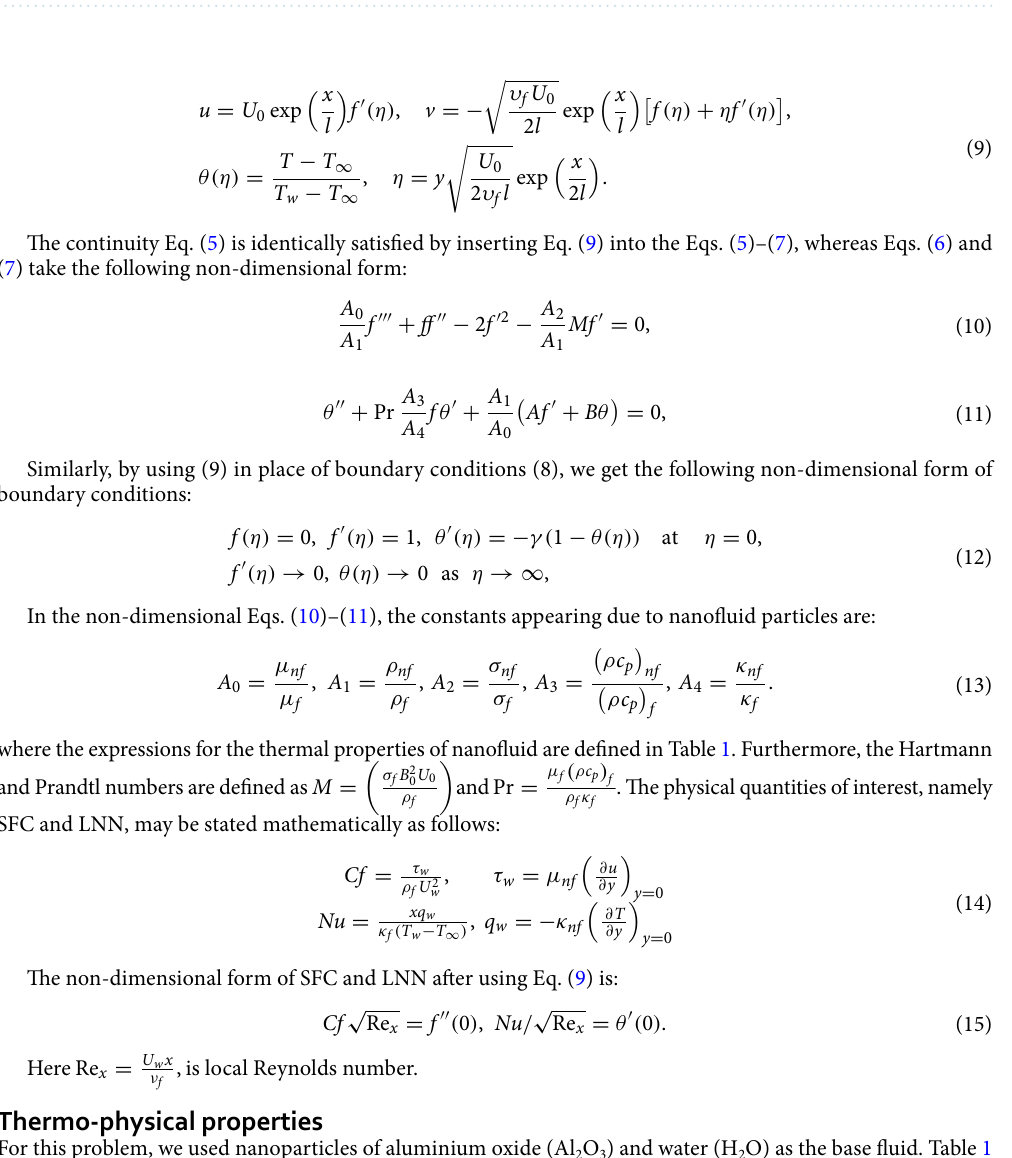
Table 1. Mathematical expressions for nanofluid thermo-physical